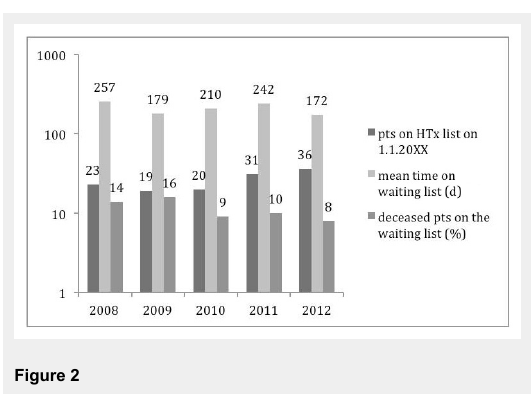
HTx waiting list characteristics (adapted from annual Swisstransplant